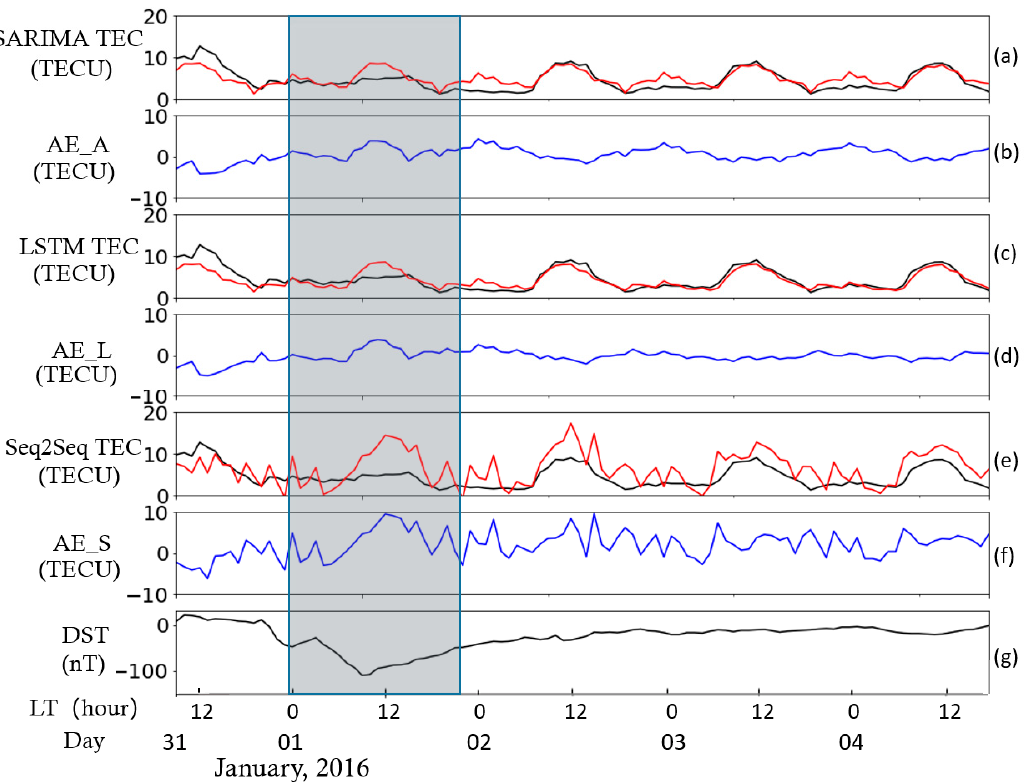
Figure 5. The TEC measurements and predictions under a major geomagnetic storm from 31 December 2015 to 4 January 2016. All panels have identical format to Figure 4. Panels ( a ), ( c ), and ( e ) are the measured TEC data (black) and the predicted TEC data (red) by the autoregressive integrated moving average (ARIMA), LSTM, and Seq2Seq methods. Panels ( b ), ( d ), and ( f ) are the absolute errors (blue) between predicted TEC and actual TEC. Panel ( g ) is the geomagnetic disturbance index Dst, and minimum Dst = − 110 nT.